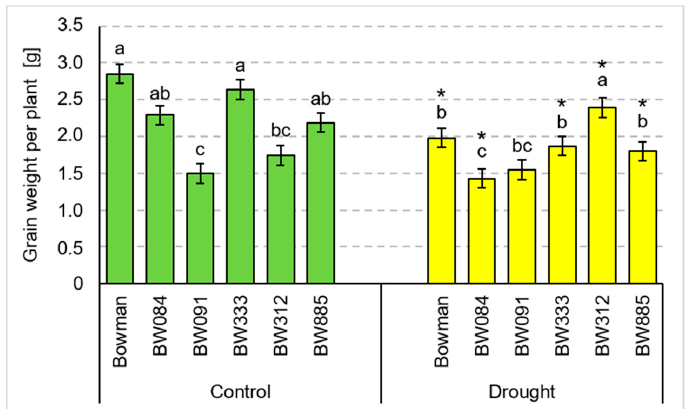
Figure 4. Average grain weight per plant of the analyzed genotypes under the optimal watering (control) conditions and after the drought stress (the pot experiment). The mean values ± (SD) marked with the same letters (separately for the control and drought-stressed plants) are not significantly different, according to Duncan’s test ( p ≤ 0.05). Asterisks denote significant difference in comparison of values reported in each genotype between the control and drought conditions according to Student’s t -test. Details are given in the text.